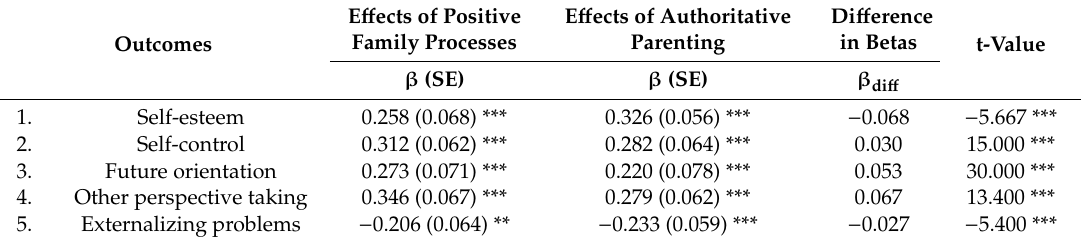
Table 7. Comparison of e ff ects of authoritative parenting and positive family processes on youth